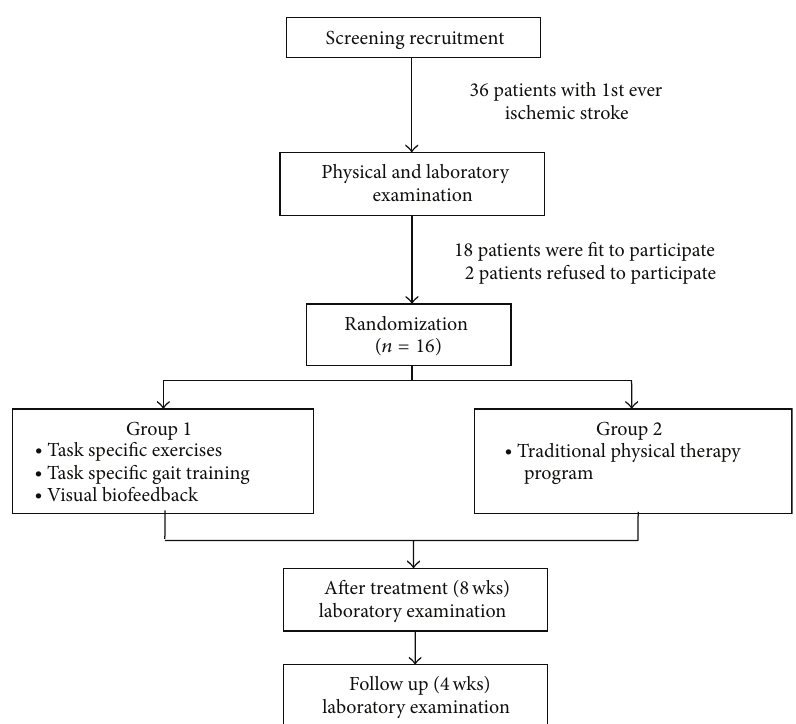
Figure 1: Flow of study from screening to completion of the follow-up